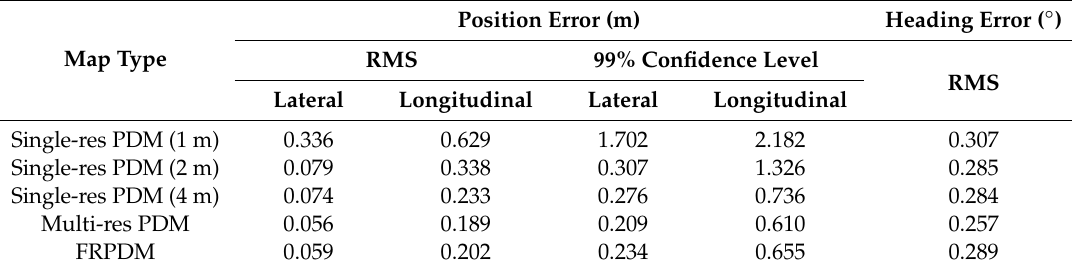
Figure 33. GPS / DR increment error. Figure 33. GPS/DR increment error. Table 3. Comparison of localization performances (map type). Table 3. Comparison of localization performances (map type).